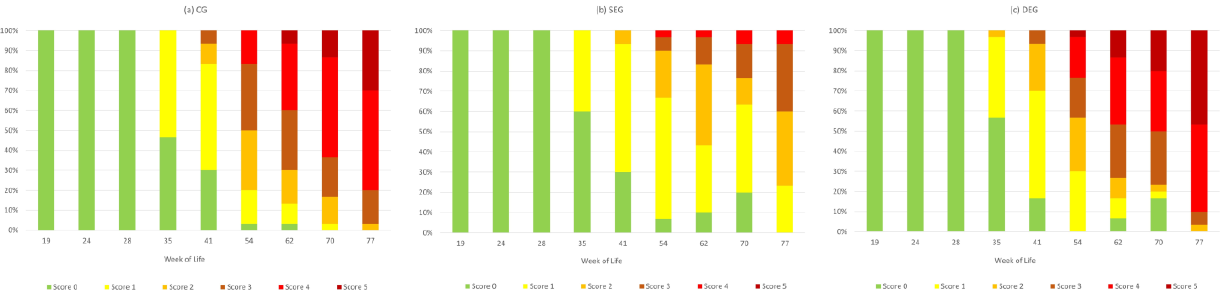
Figure 3. Percentage of animals with a plumage score of 0 (intact plumage) to 5 (<75% of feathers missing) in at least one body region in the three groups: ( a ) CG = control group, ( b ) SEG = single enrichment group, and ( c ) DEG = double enrichment group during the husbandry period (weeks of life 19 – 77).